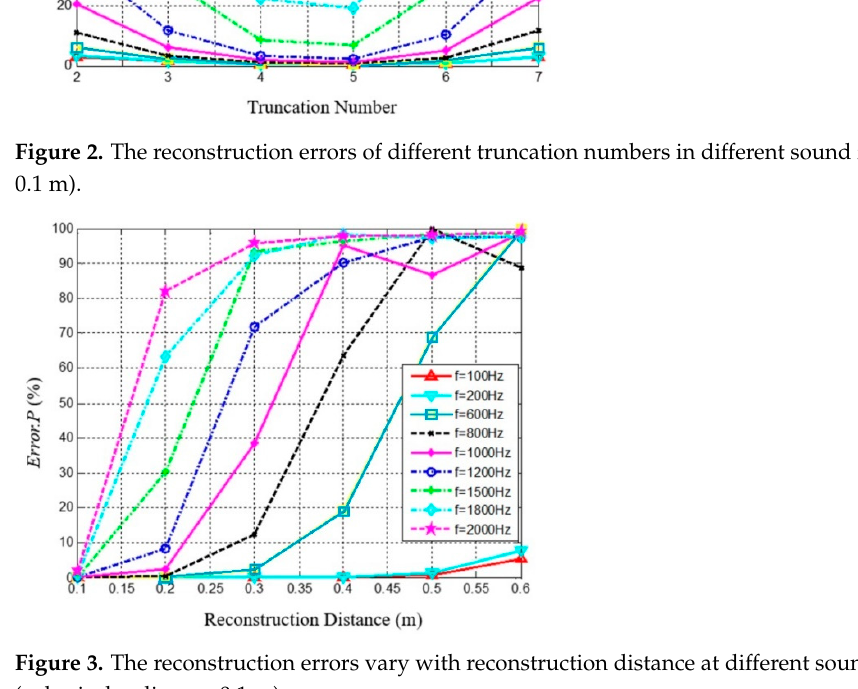
Figure 2. The reconstruction errors of different truncation numbers in different sound fre- quency ( r = 0.1 m).